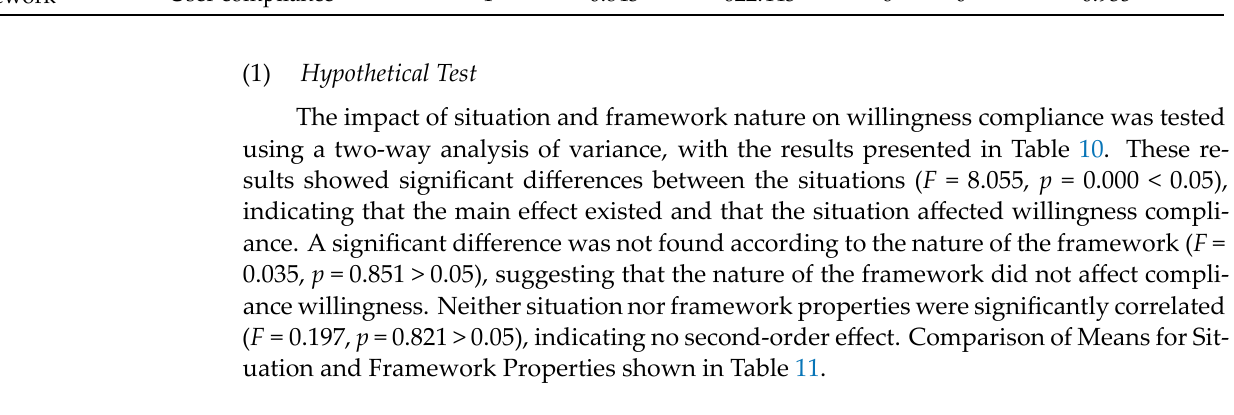
Table 10. Two‑Way ANOVA